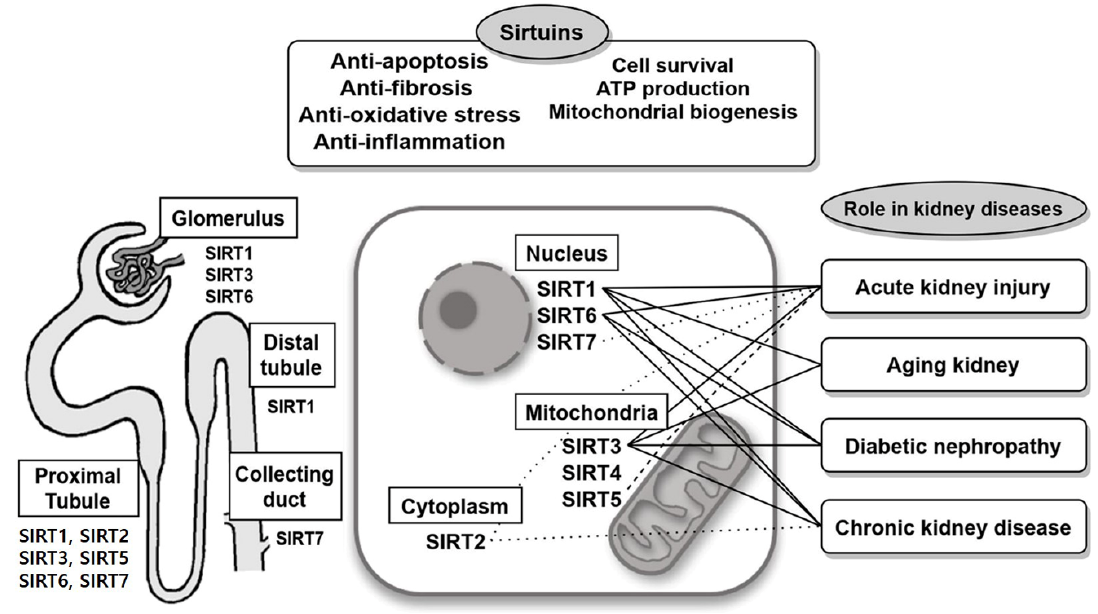
Figure 1. Implication of sirtuins in various kidney diseases associated with variable cellular location of sirtuins and associated pathways. The types of lines (solid line: attenuation of disease, dotted line: aggravation of disease, dash line: controversial) between each sirtuin with kidney disease were based on previous studies.